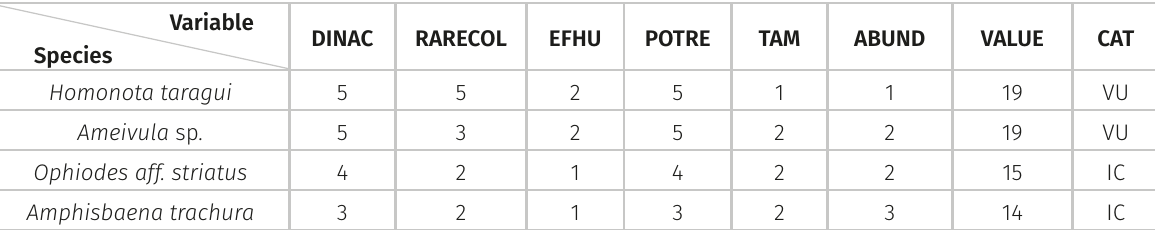
Table III. Comparison of the herpetofauna of the rocky outcrops of Paraje Tres Cerros (PTC) and that of other